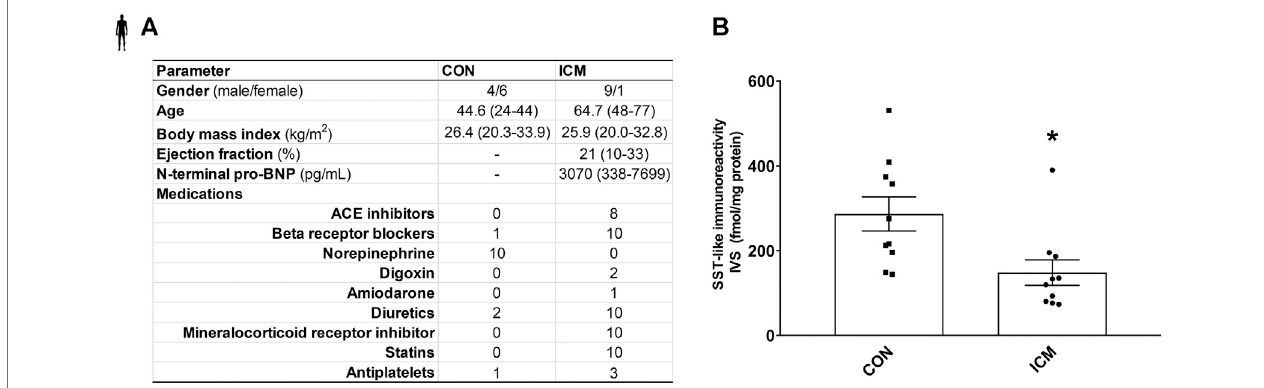
TABLE 2 | Expression of SST and its receptors in human left ventricular samples measured by mRNA sequencing. Gene